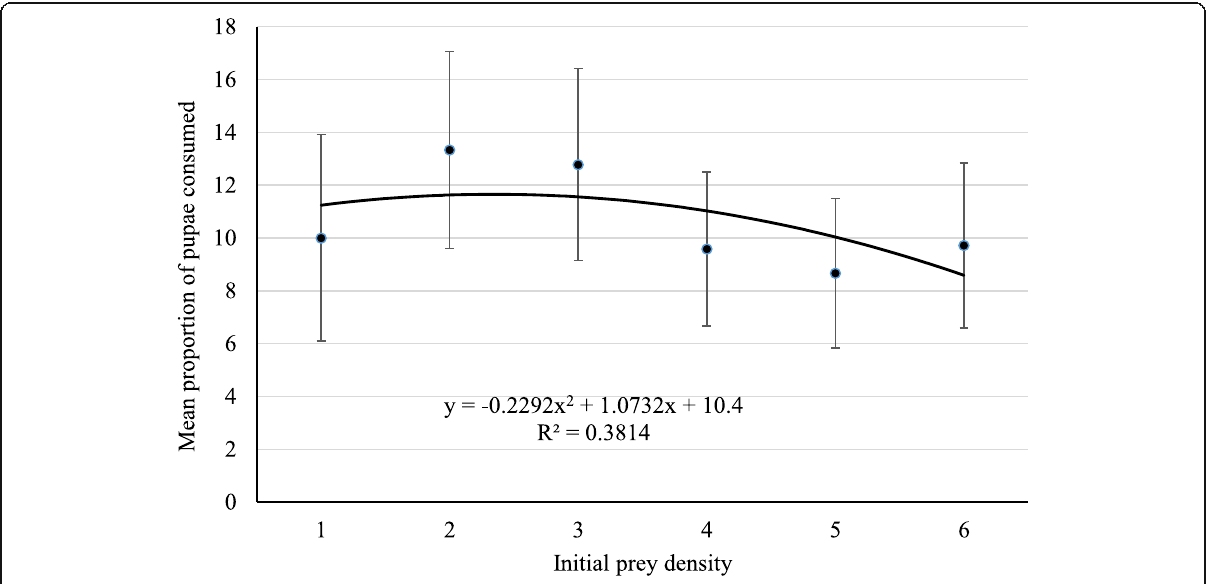
Fig. 2 Mean proportion of P. truncatus pupae consumed by A. biannulipes at six different densities